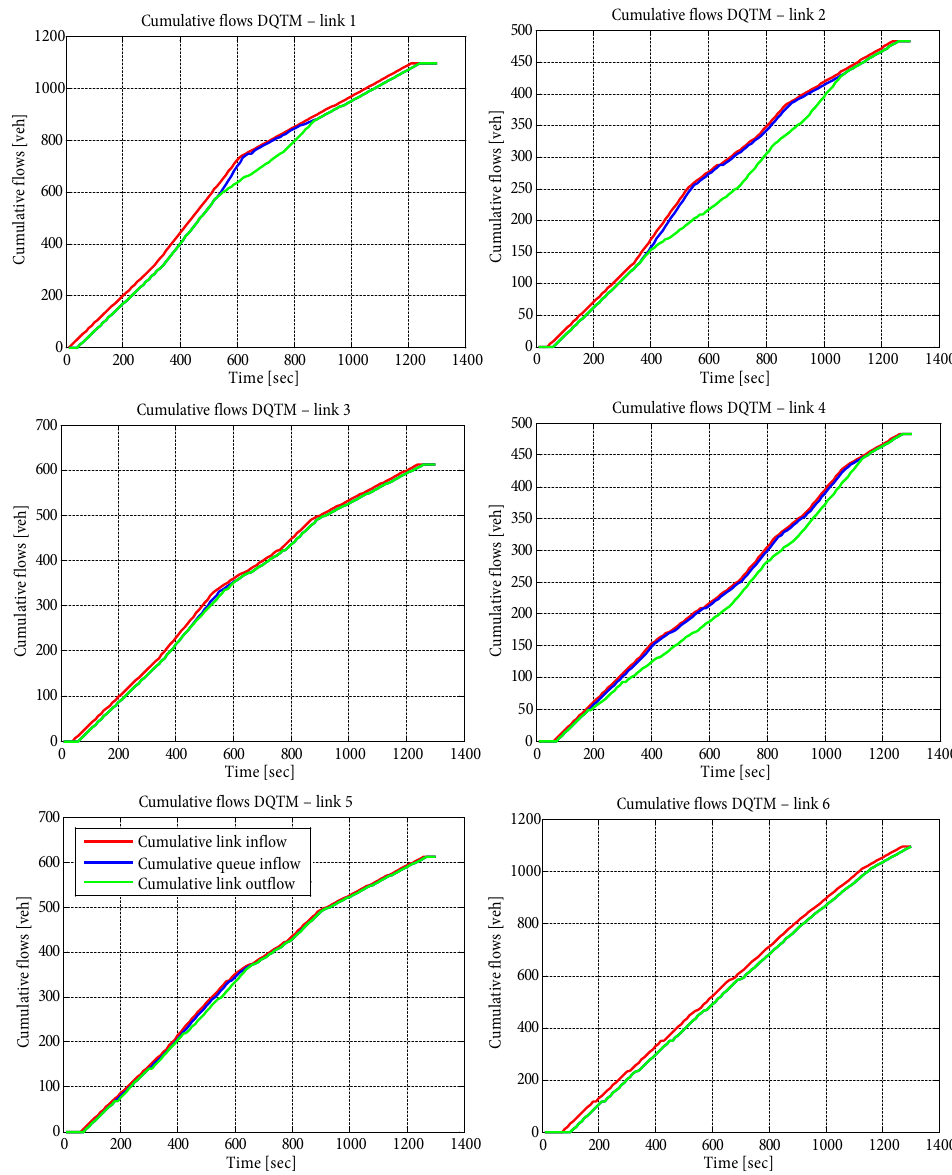
Fig. 5. Cumulative flows for single-class